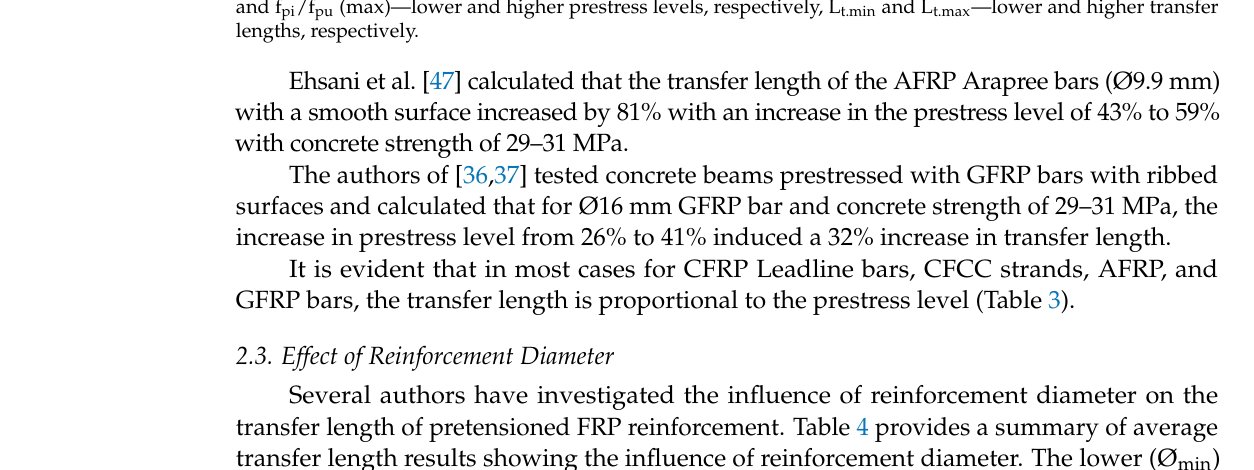
Table 4. Summary of the transfer length results for the influence of reinforcement diameter of the FRP reinforcement.